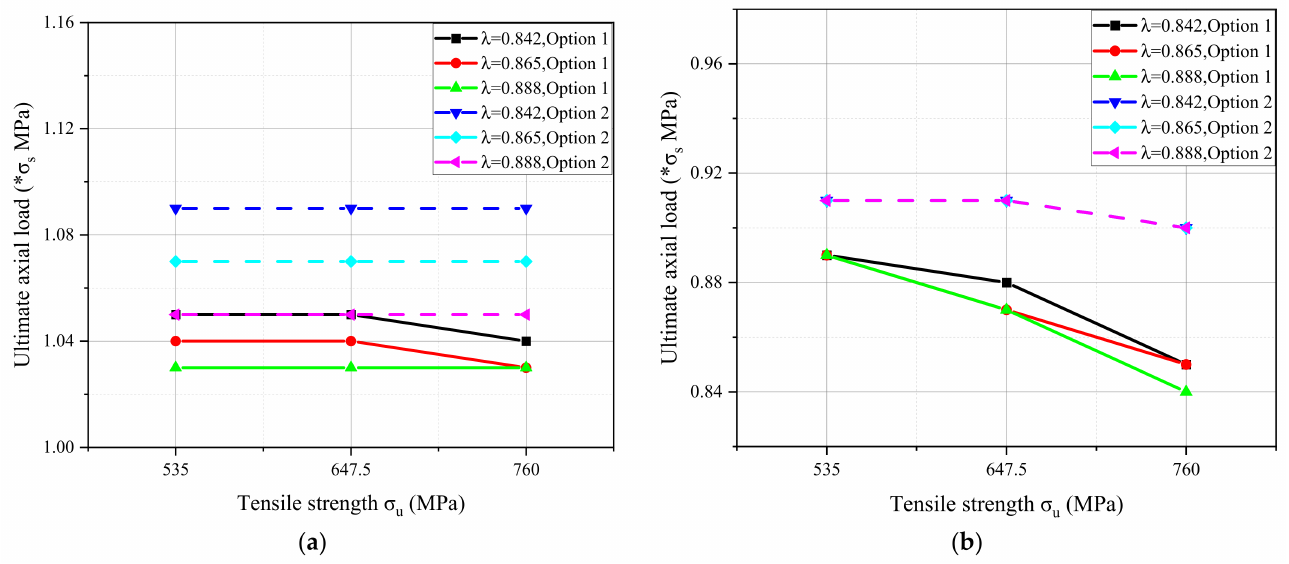
Figure 14. Effect of material properties on the ultimate axial load of pipeline girth weld cracks. ( a ) a/B = 0.1; 2 c/ π D = 0.01; ( b ) a/B = 0.3; 2 c/ π D =